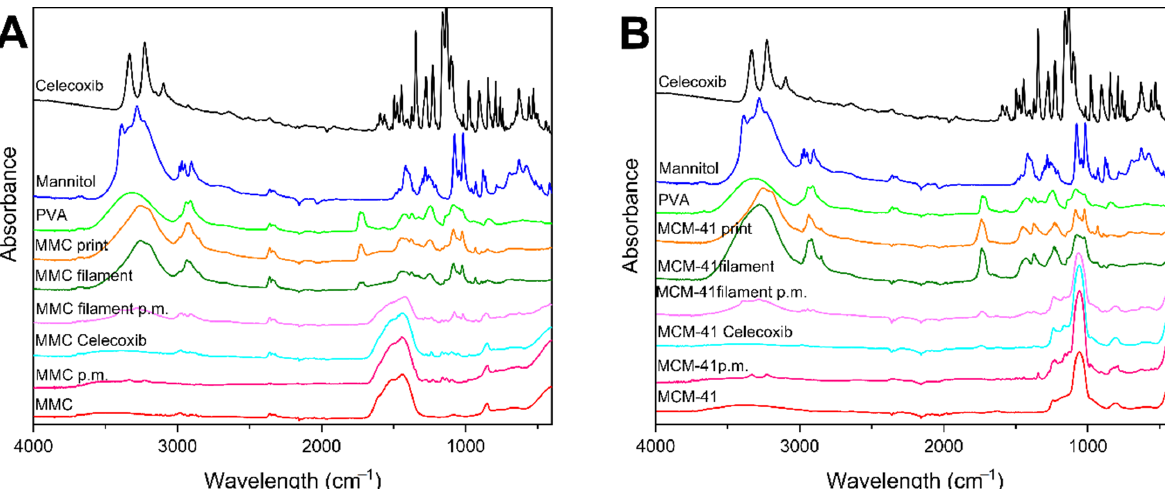
Figure 3. ATR – FTIR spectra of filaments, tablets, and individual components; ( A ) MMC-containing formulations: MMC p.m. is the physical mixture of MMC and celecoxib, MMC Celecoxib is drug-loaded MMC, and MMC filament p.m. is the physical mixture of the filament components; ( B ) MCM-41-containing formulations: MCM-41 p.m. is the physical mixture of MCM-41 and celecoxib, MCM-41 Celecoxib is drug-loaded MCM-41, and MCM-41 filament p.m. is the physical mixture of the filament components.